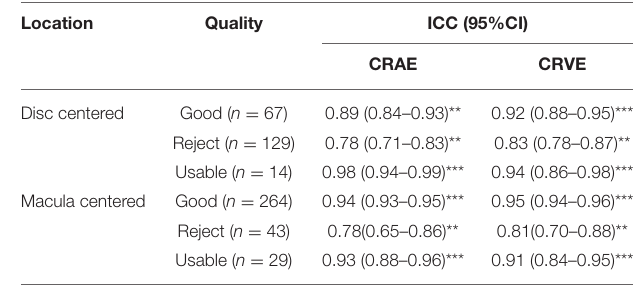
TABLE 4 | Agreement estimates of retinal-vessel caliber in the Standard zone for measurements on RMHAS segmentation and manual segmentation.